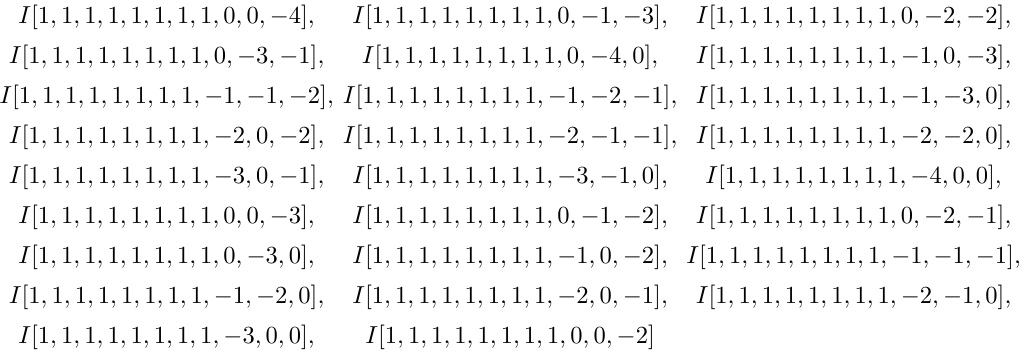
Figure 8 . Integrals up to numerator degree 4 without double propagators for the nonplanar double pentagon